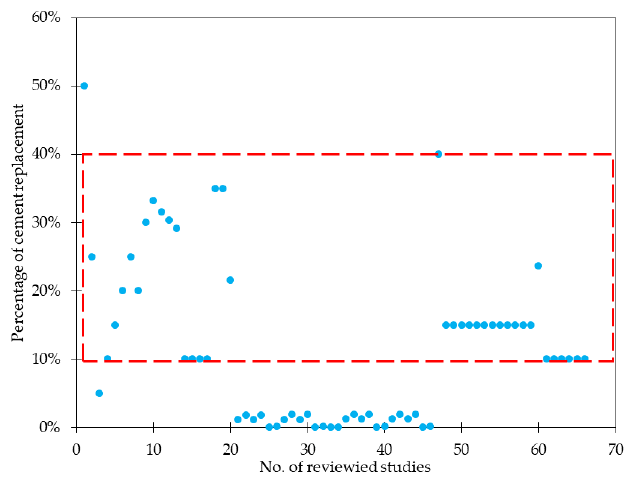
Figure 2. Cement replacement in studies presented in Table 3.